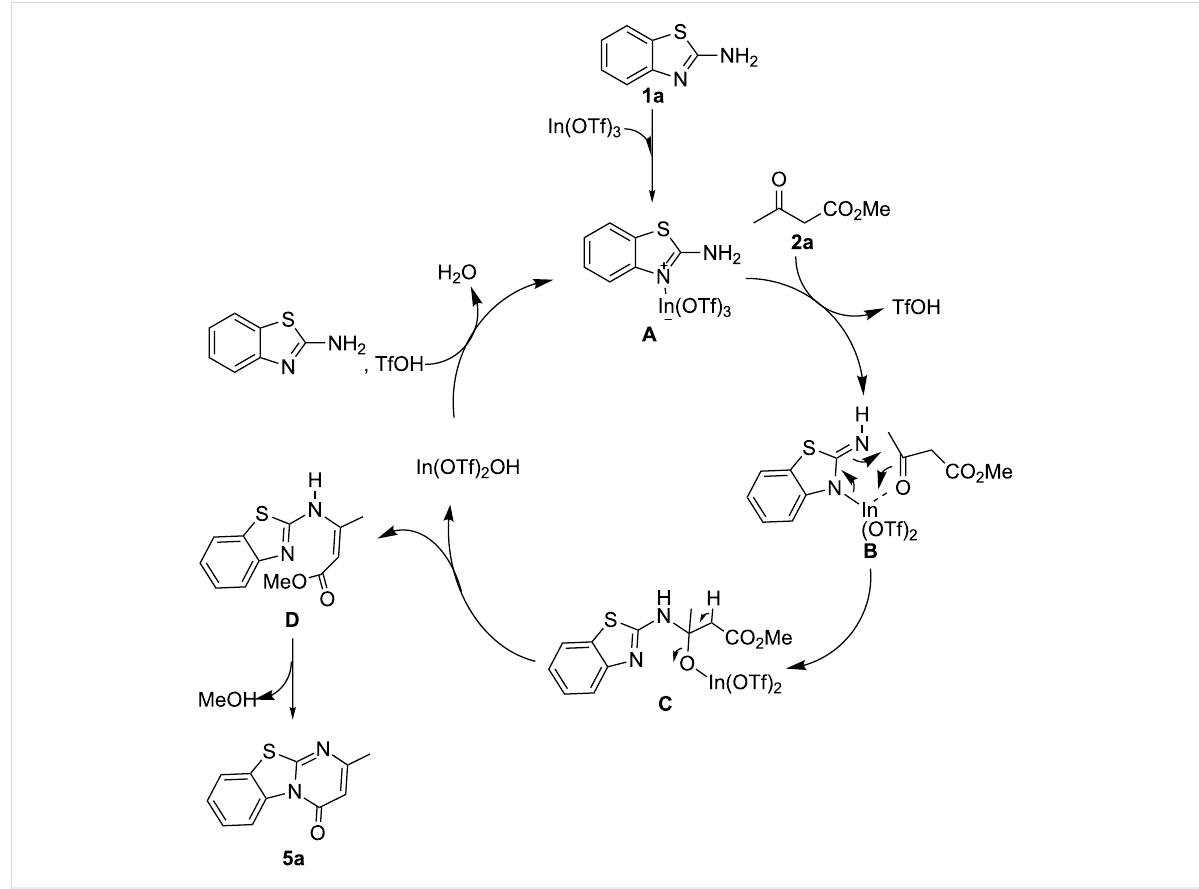
Figure 2: Proposed mechanism (benzo[4,5]thiazolo[3,2- a ]pyrimidin-4-ones).